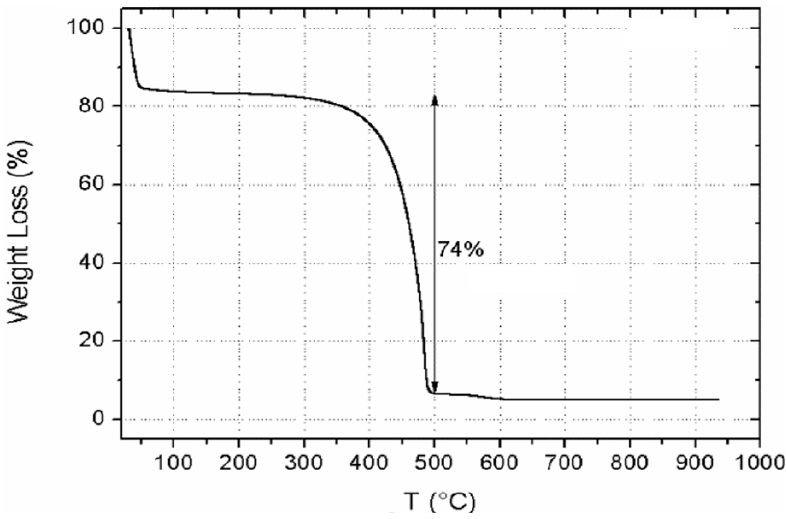
Figure 4. TGA curve of biochar.